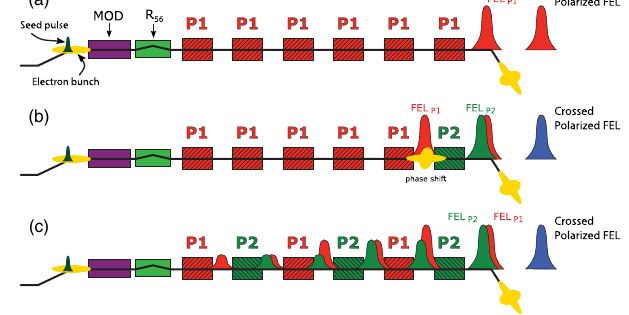
FIG. 2. Schematic representation of the FEL-1 setup. In the normal configuration (a) all the modules constituting the radiator are tuned to the same polarization state to emit polarized FEL radiation [circular right (CR), circular left (CL), linear vertical (LV) or linear horizontal (LH)]. The crossed polarized undulator scheme instead can be implemented as a superposition of two consecutive sources (b) or in a distributed scheme (c). Red and green represent undulators with two orthogonal polarizations (P1 and P2) that can be either CR — CL, or LH — LV that produce FEL pulses with corresponding polarization properties (FEL and FEL ). The labels MOD indicates the modulator undulator, P 2 R 56 the dispersive section. Image adapted